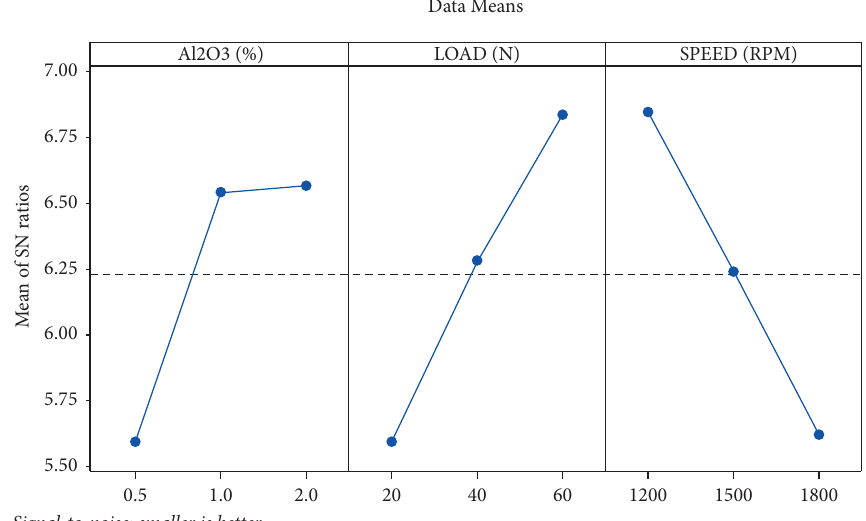
Figure 11: Main efect plot for signal-to-noise ratios for coefcient of friction.